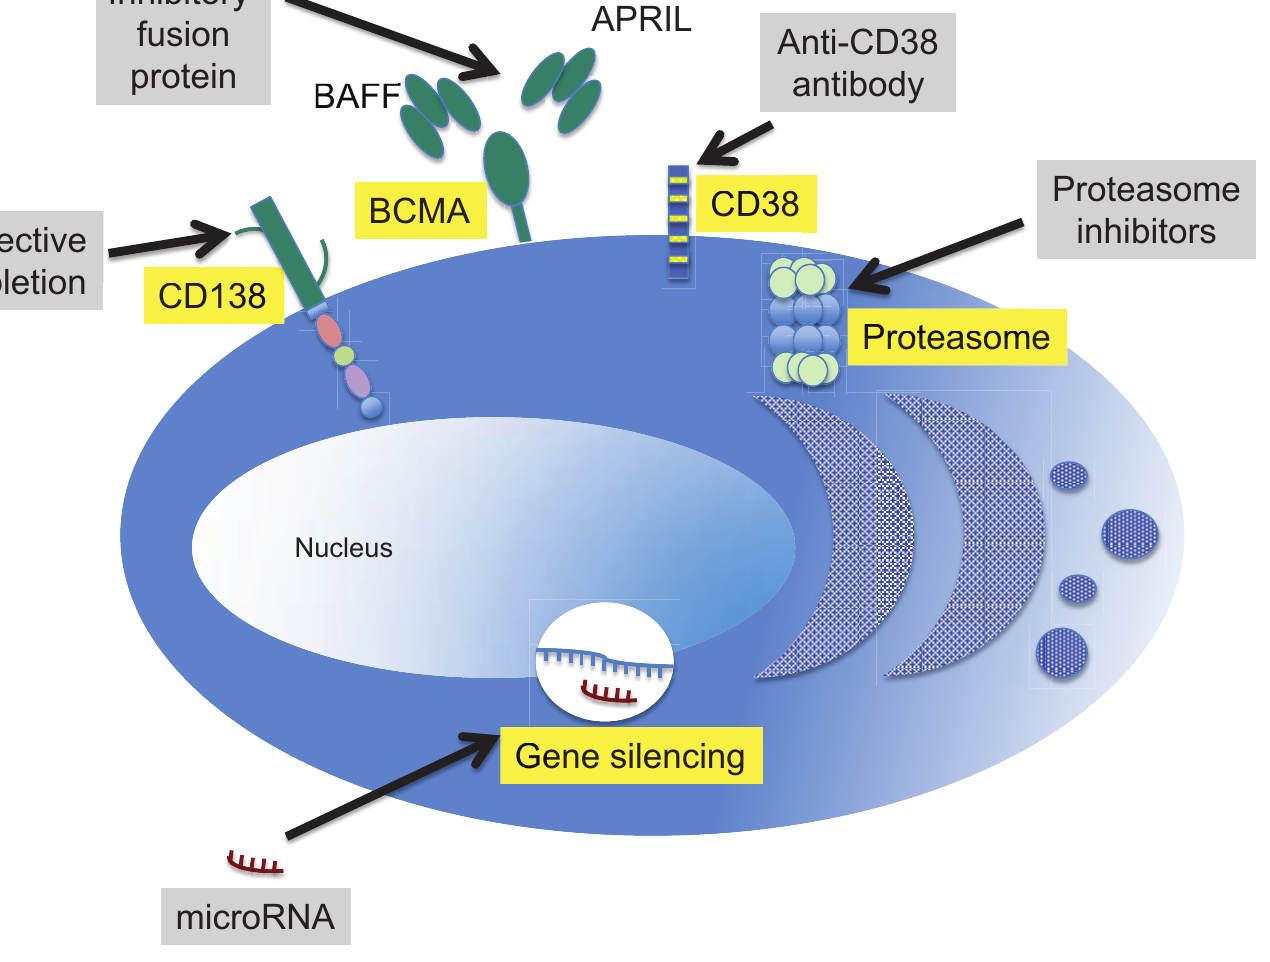
Figure 1. Potential therapeutic targets that are of potential use in autoimmune diseases. Each target is discussed in detail in the text.